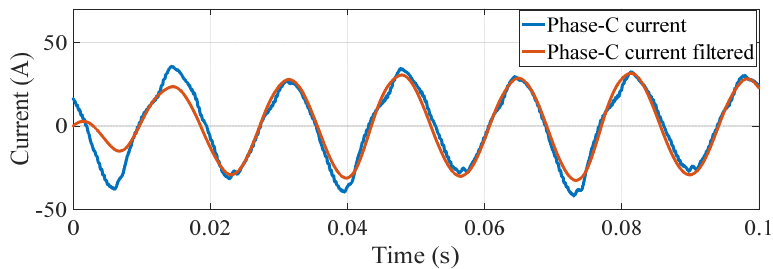
Figure 17. Comparison Between the Unscaled PCS100 Phase C Current Before and After Filtering with the Band-Pass Filter.